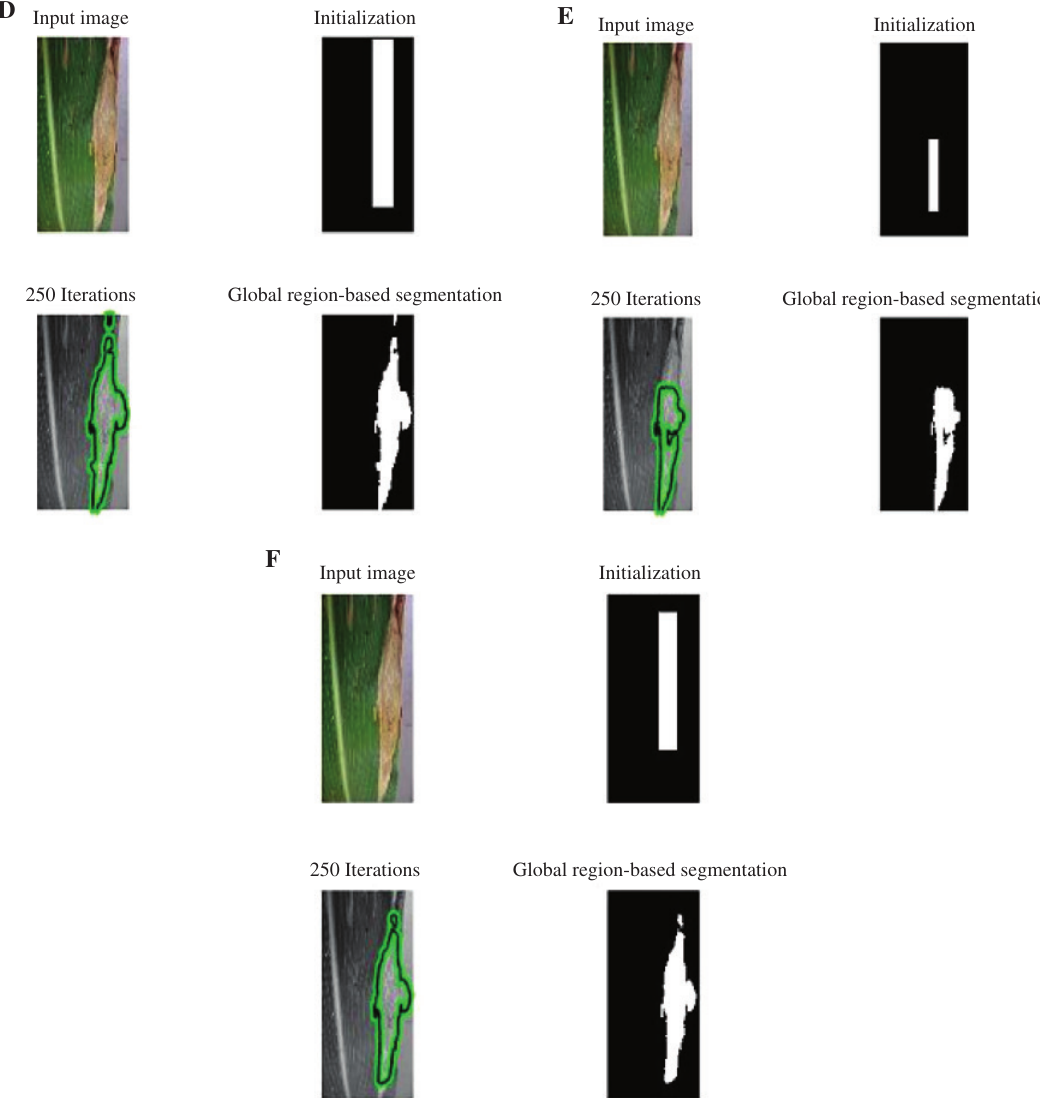
Figure 7: The Output Result of Image